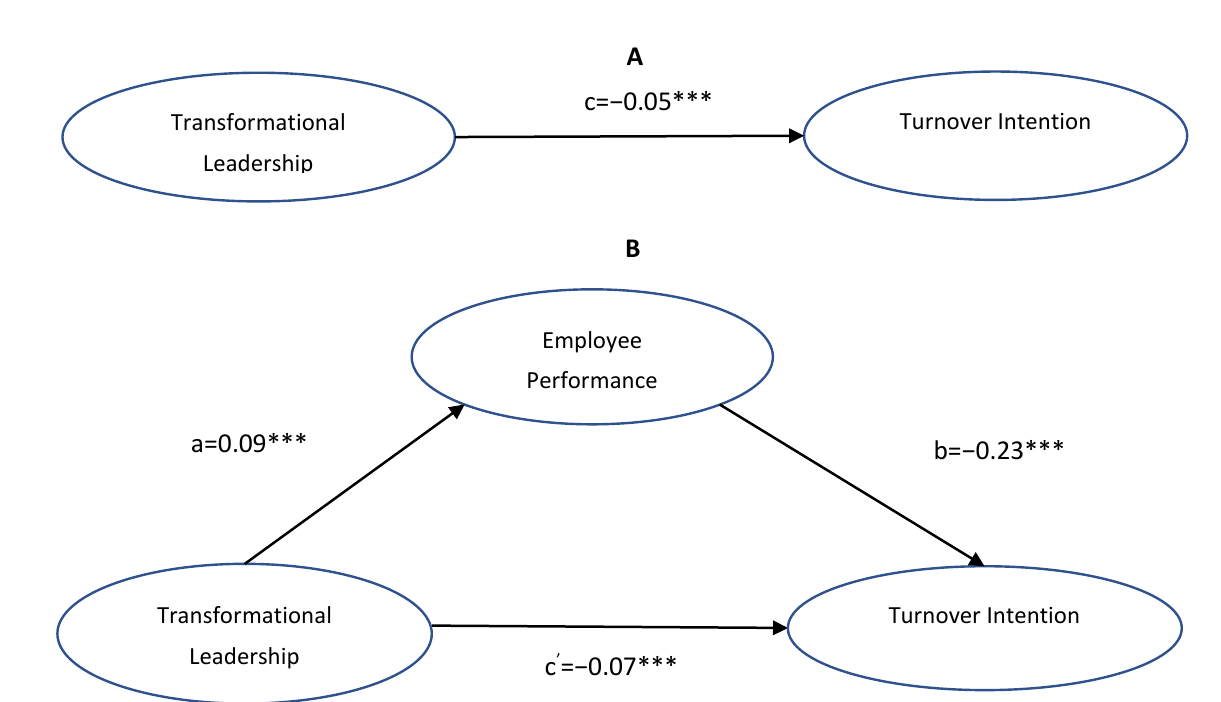
Figure 1. Hypothesized model tests. Tests of the hypothesized models. ( A ) Total effect (transformational leadership predicting turnover intention). ( B ) Indirect effect, with employee performance as mediator. Indirect effect β = − 0.02, SE = 0.01. The predictor accounted for 48% of the variance in turnover intention. Standardized regression coefficients are display *** p < 0.001. Table 3. Bootstrap results to test significance of mediation effects ( Direct and Indirect Effects ).